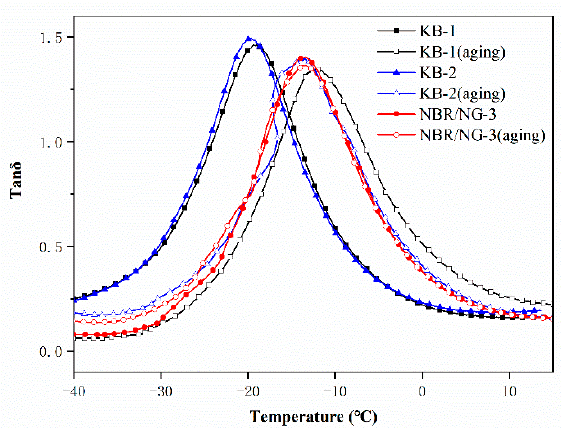
Figure 12. Loss factor (tan δ ) curves of KB-1, KB-2, and NBR/NG-3.